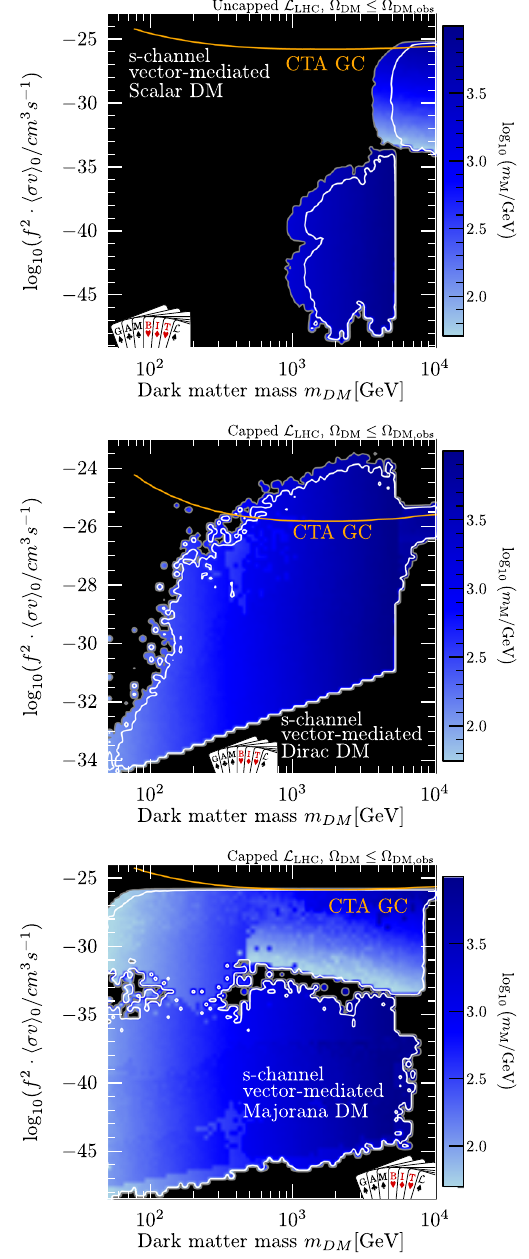
Fig. 10 Allowed parameter space as a function of the DM mass and rescaled annihilation cross section. Capped collider likelihoods are shown for Dirac (middle) and Majorana (bottom) DM as these are the least constraining. The non-capped likelihood is shown for the scalar DM model (top). The solid red line indicates the projected “initial con- struction” sensitivity of the Cherenkov Telescope Array (CTA) towards the Galactic Centre (GC). The contour is coloured to indicate the medi- ator mass that gives the highest likelihood for a given DM